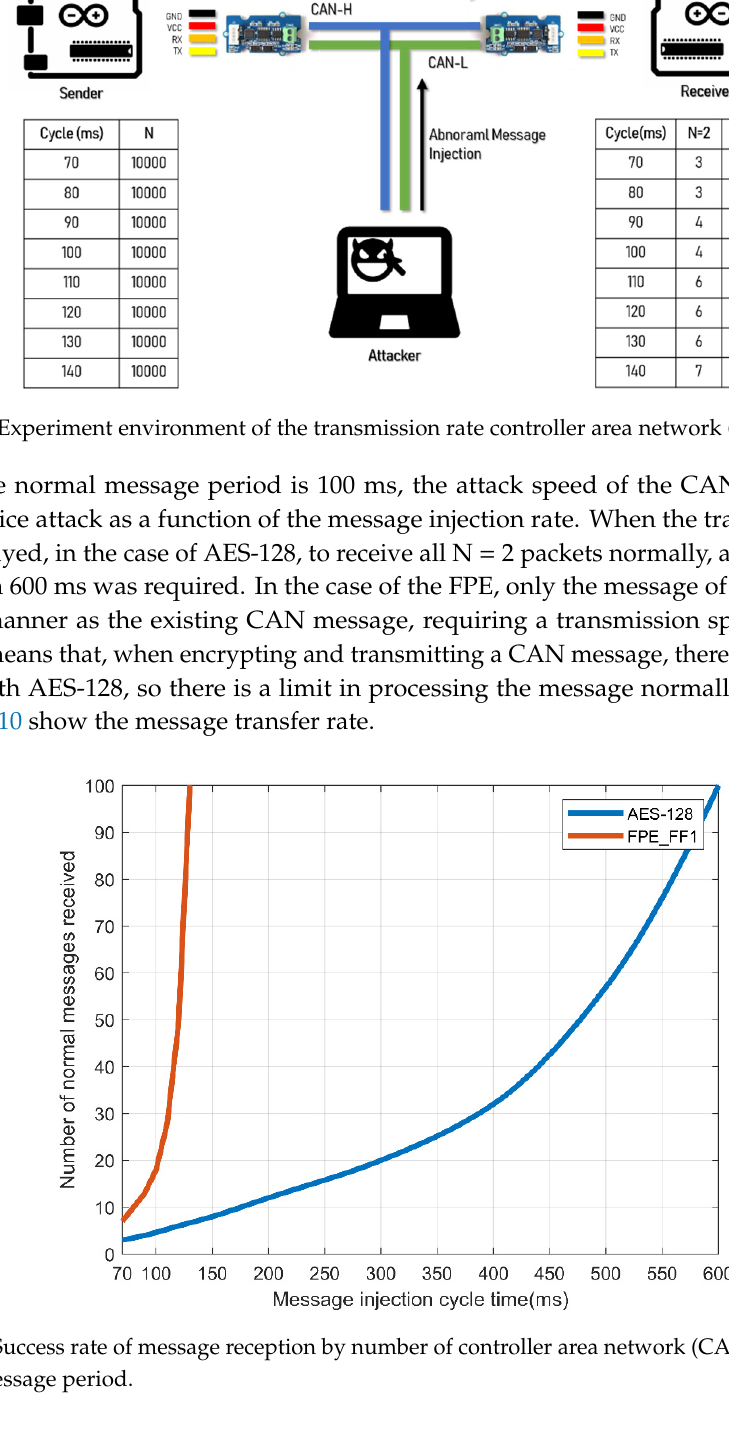
Figure 10. Loss rate of message reception by number of controller area network (CAN) messages in a normal message period. When the normal message period is 100 ms, the attack speed of the CAN is delayed as in a denial-of-service attack as a function of the message injection rate. When the transmission speed of CAN was delayed, in the case of AES-128, to receive all N = 2 packets normally, a transmission speed of no less than 600 ms was required. In the case of the FPE, only the message of N = 1 was received in the same manner as the existing CAN message, requiring a transmission speed of no less than 130 ms. This means that, when encrypting and transmitting a CAN message, there is a delay in normal processing with AES-128, so there is a limit in processing the message normally compared to FPE. Figures 9 and 10 show the message transfer rate. In addition, we measured the normal reception rate for 100 messages with a normal message period ranging from 150 to 500 ms. The experimental results are shown in Table 8. Table 9. Controller area network (CAN) message reception rate with AES-128. Cycle